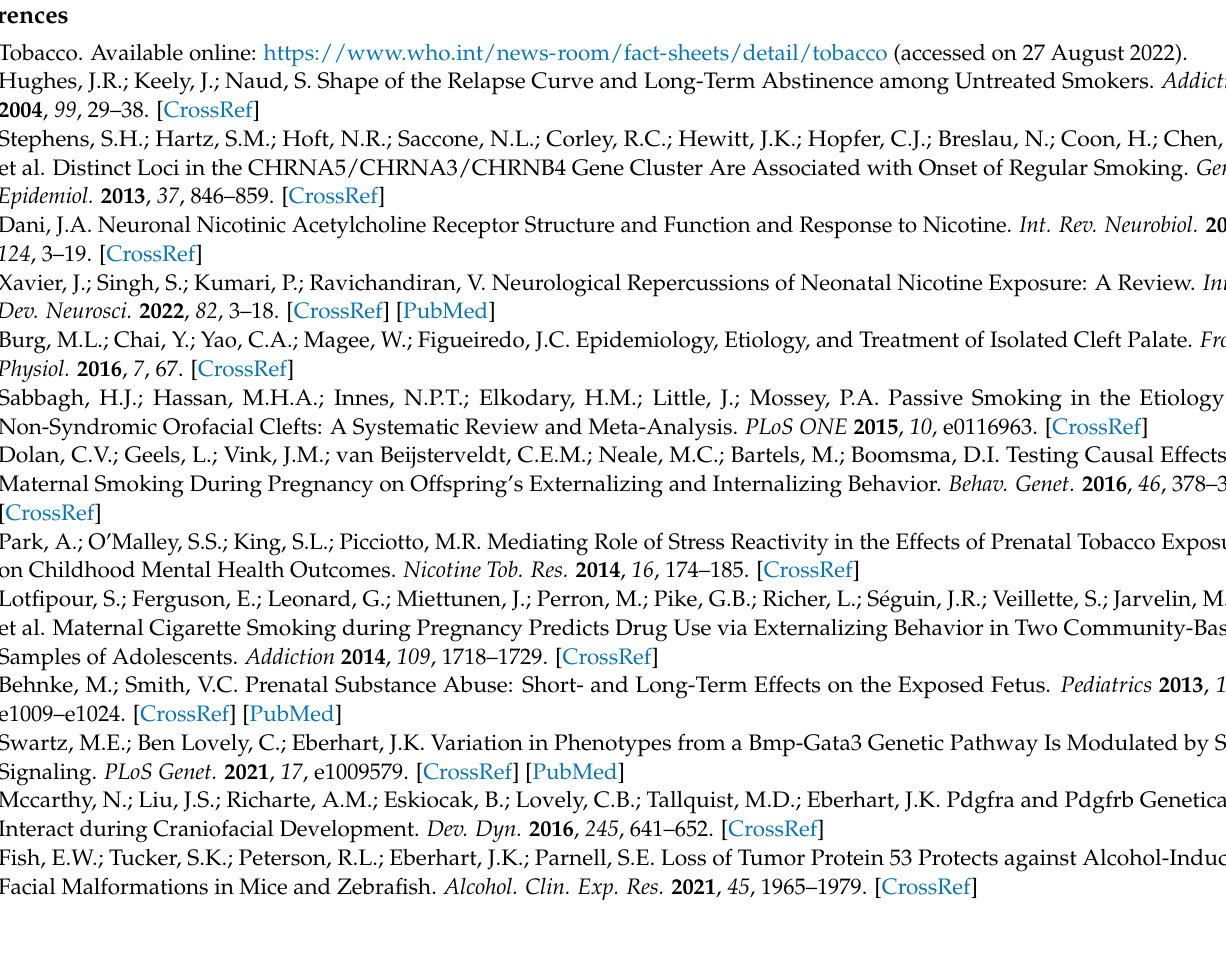
Figure S3. Body Length; Figure S4. Average distance from the live shoal minute by minute between the DMSO and 12.5 µ M Nicotine groups, when the shoal is visible. Table S1: Figure 3. ANOVA p -value summary; Table S2: Figure 4. ANOVA p -value summary; Table S3. Average distance from the live shoal minute by minute between the DMSO and 12.5 µ M Nicotine groups, when the shoal is